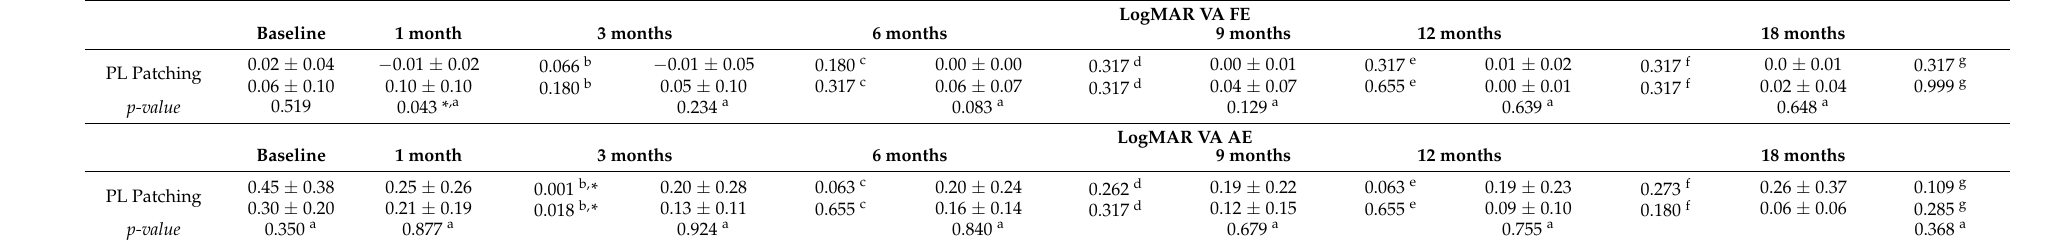
Table 2. Visual acuity measures during the follow-up. PL: Perceptual learning